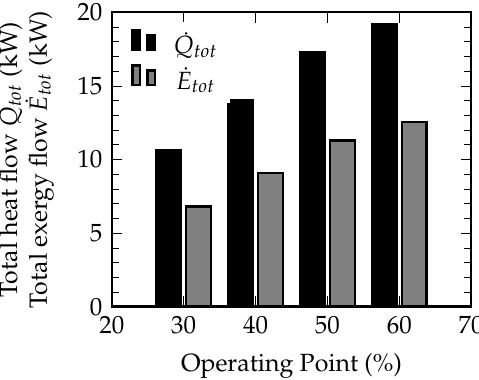
Figure 9. Total heat flow and total exergy flow depending on the operating point.